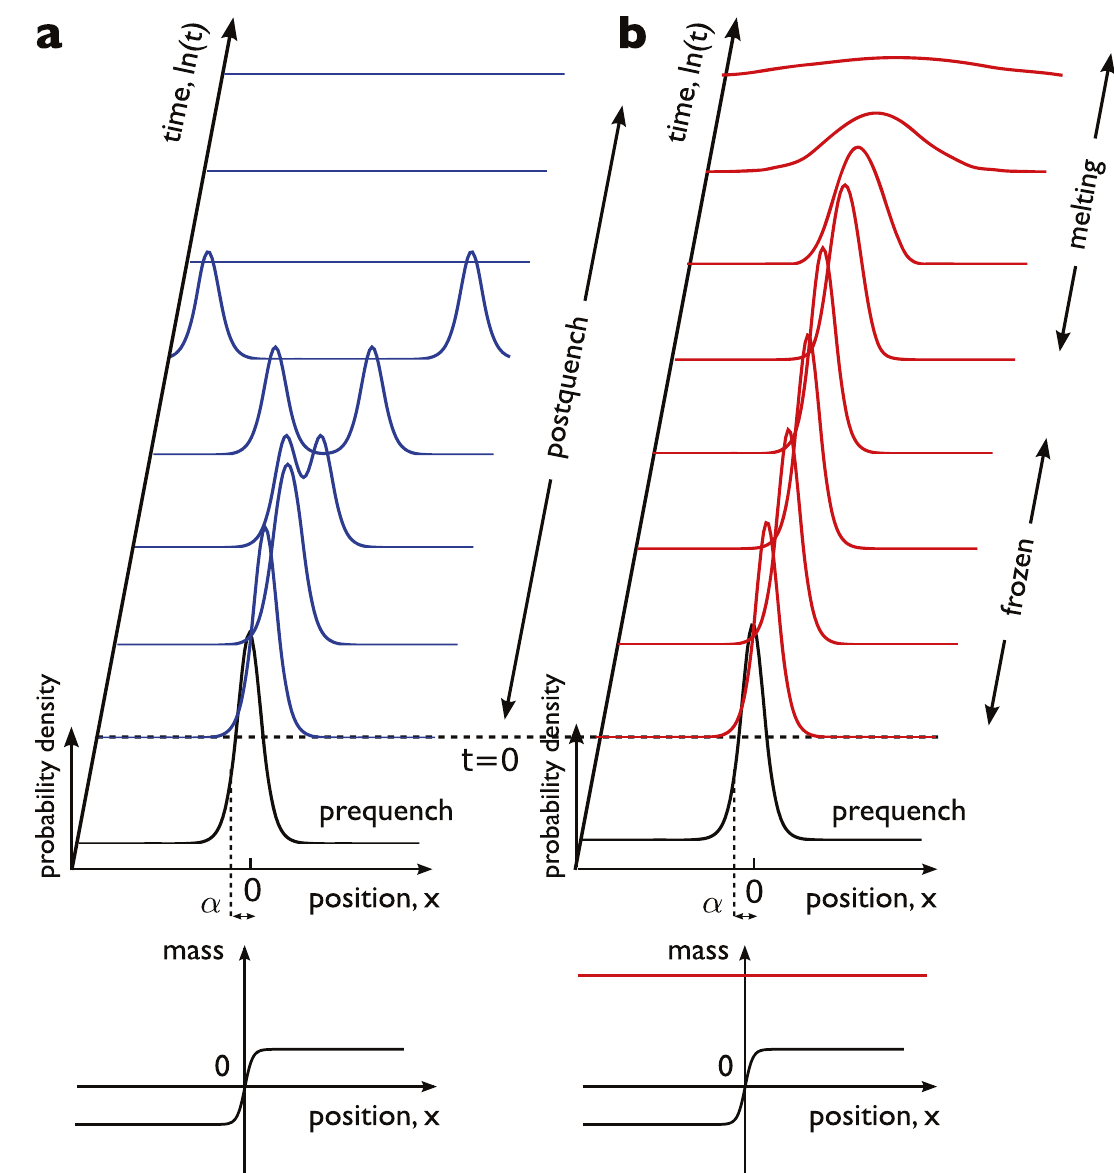
Fig. 1 Emergence of frozen and melting regimes after a boundary mode is quenched. a Postquench evolution of the probability density of a topological boundary mode (TBM) initially localized at the mass domain wall at position x = 0; in this case where m = 0 after the quench at time t = 0, wavetrains move away from the domain wall for t > 0. b Slow decay of the same TBM probability density for large postquench uniform dimensionless mass m α / _ v = 20, α is the domain wall width, _ the reduced Planck constant, and v the Fermi velocity. It displays a frozen probability density regime as well as a melting regime exhibiting a power-law decay of the TBM probability density. The prequench mass distribution is the same as in a , with a domain wall at x = 0, but the postquench mass m α / _ v = 20 is large (red). In all panels probability density snapshots are plotted using Eq. (4) taken at logarithmic time spacings. We used the initial TBM pro fi le Φ ( x ) = sech( x / α ) from Eq.